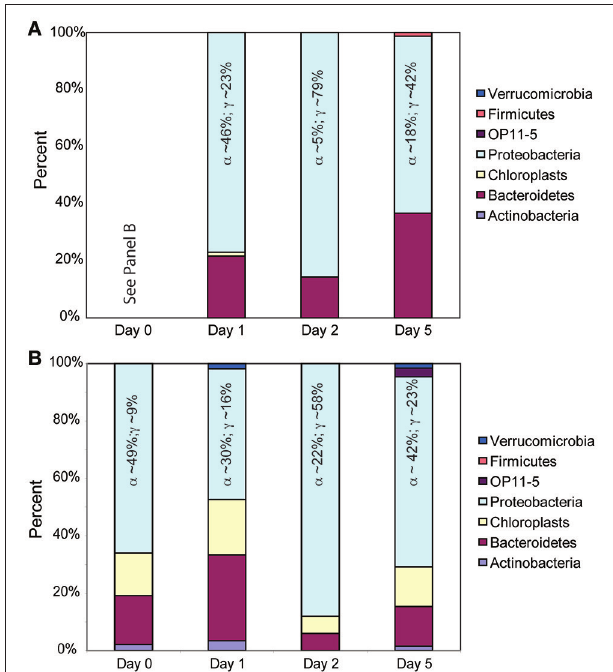
FIGURE 7 | Relative contributions of different bacterial phyla in 16S rDNA clone libraries. Panel (A) represents the clones from the < 1.0- µ m treatments and Panel (B) represents the clones from the whole water incubations. Colors in the bars follow the sequence provided in the legend. The Day 0 bar in Panel (B) represents the initial seawater prior to 1.0- µ m filtration and is applicable to both Panels (A,B) . Within the Proteobacteria, the contributions of the two primary classes are given ( α -proteobacteria and γ -proteobacteria).